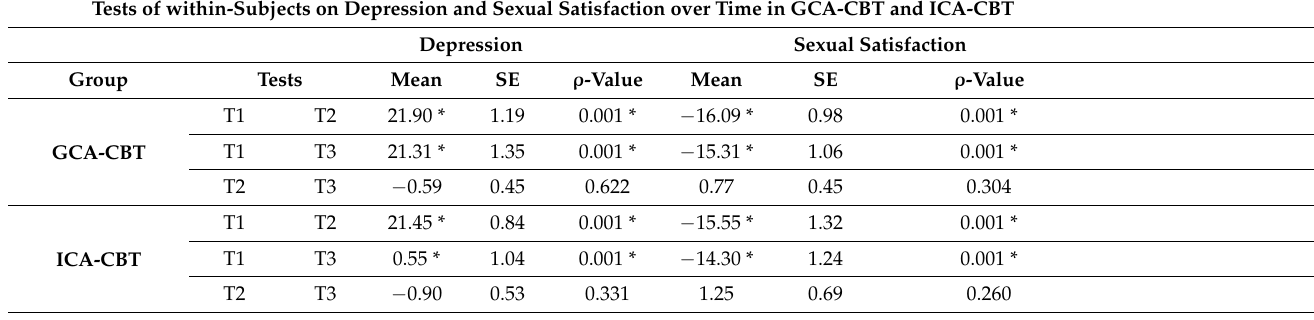
Table 3. Repeated Measures ANOVA for T1, T2, and T3 for GCA-CBT and ICA-CBT. Tests of within-Subjects on Depression and Sexual Satisfaction over Time in GCA-CBT and